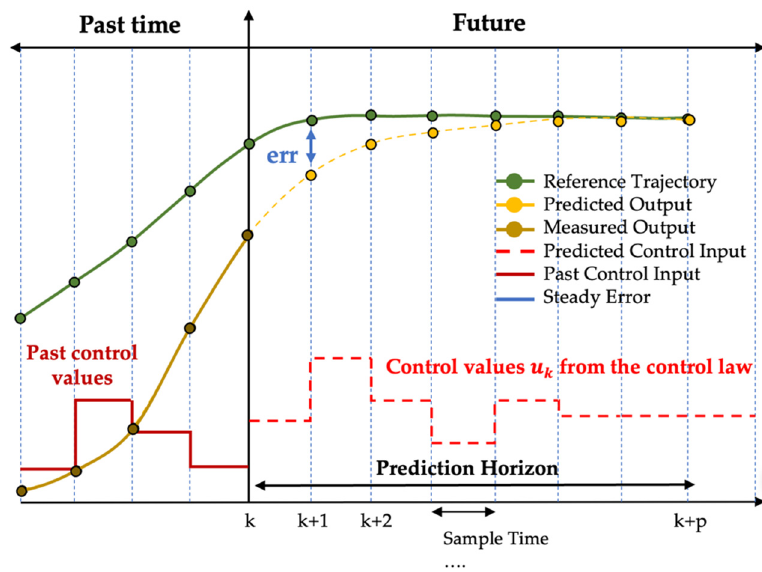
Figure 6. Concept of Model Predictive Control.